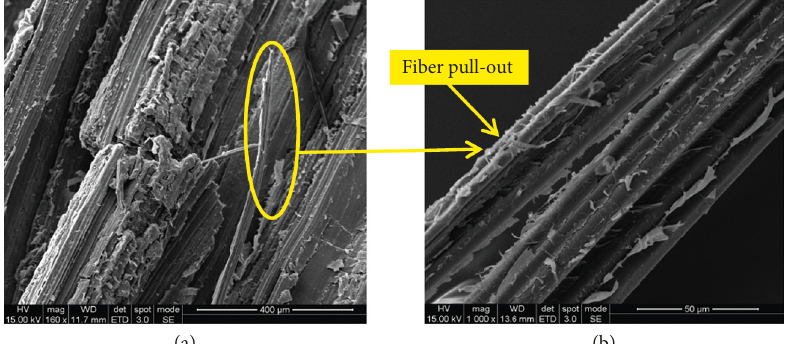
Figure 9: (a) SEM micrograph of the DCB specimens’ fracture surface for PSB composite. (b) Fiber pull-out with higher magnitude.